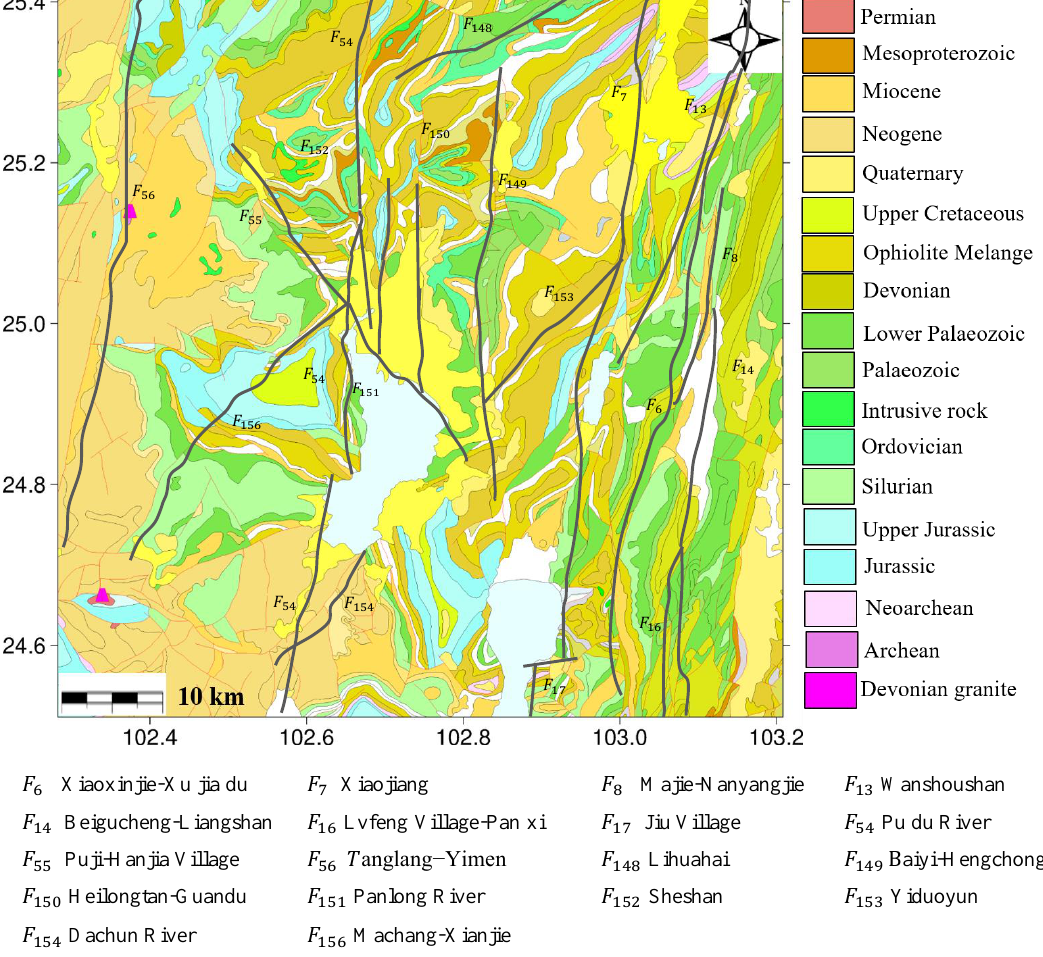
Figure 3. Geological map of study area. The black solid line represents quaternary active faults [4].